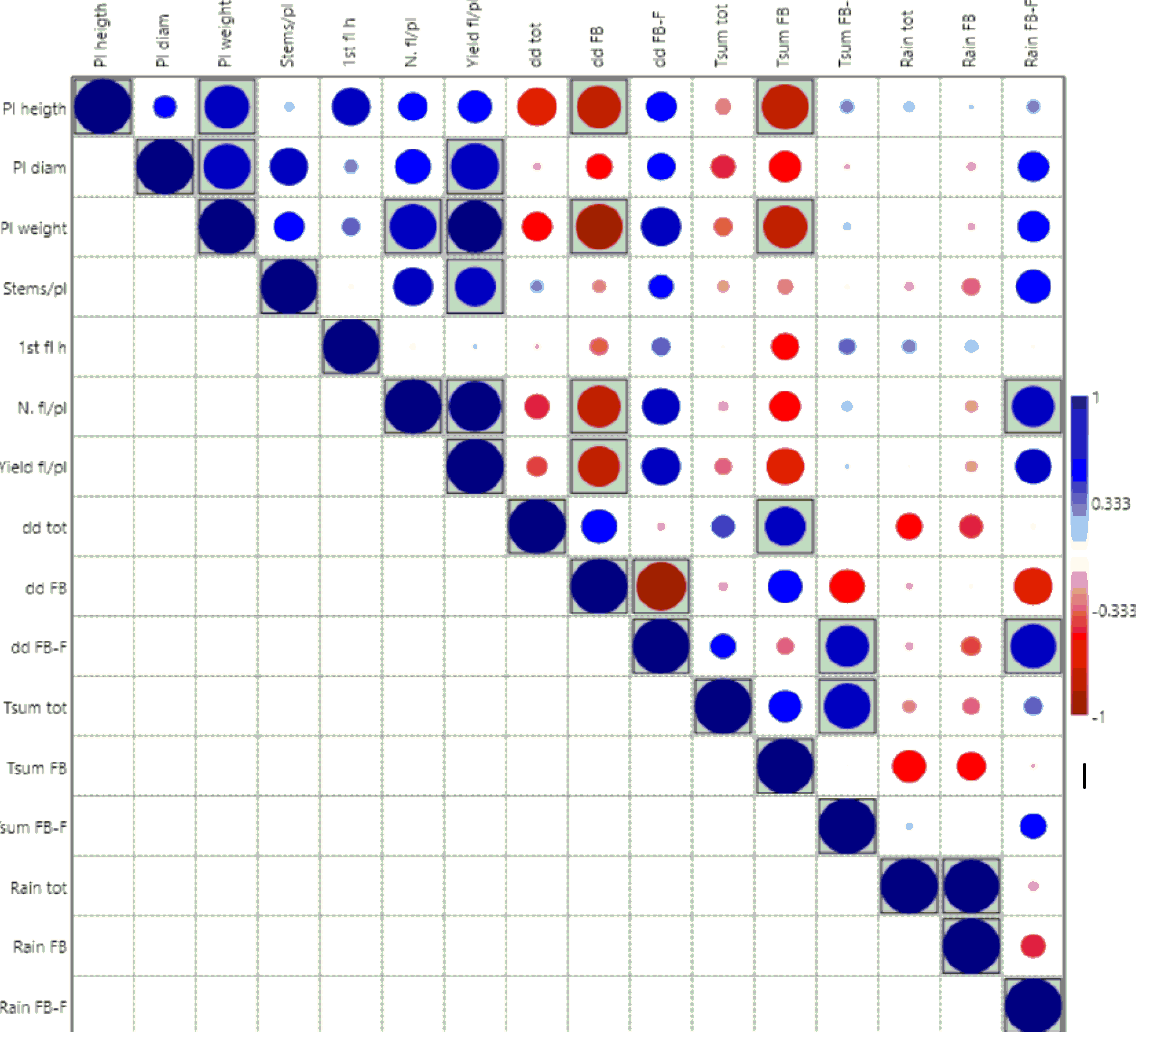
Figure 4. Correlations (Pearson’s r values) plot between the major traits measured at Sparacia (Cammarata, AG, Italy) on pyrethrum plants from 2012 to 2019 and the correspondent climatic parameters. Legenda: Pl height: plant height (cm); Pl diam: plant diameter (cm); Pl weight: weight of 1 plant (g); Stems/pl: n. of stems/plant; 1 st fl h: height of the 1 st flower (cm); N. fl/pl: n. of flowers/plant; dd tot: n. of days from Jan 1 st to full flowering; dd FB: n. of days from Jan 1 st to appearance of flower buds; dd FB-B: n. days from appearance of flower buds to full flowering; Tsum tot: thermal sum from Jan 1 st to full flowering (°C); Tsum FB: thermal sum from Jan 1 st to appearance of flower buds (°C); Tsum FB-B: thermal sum from appearance of flower buds to full flowering (°C); Rain tot: rainfall amount from Jan 1 st to full flowering (mm); Rain FB: rainfall amount from Jan 1 st to appearance of flower buds (mm); Rain FB-B: rainfall amount from appearance of flower buds to full flowering (mm). Boxed r values are significant at p < 0.05.